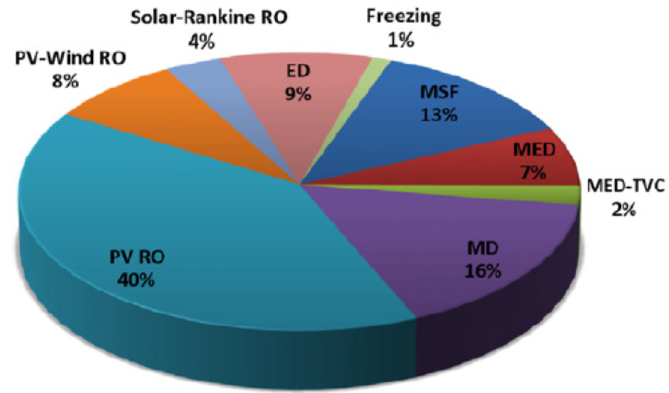
Figure 7. Share of renewable desalination technologies installed worldwide [50,51].